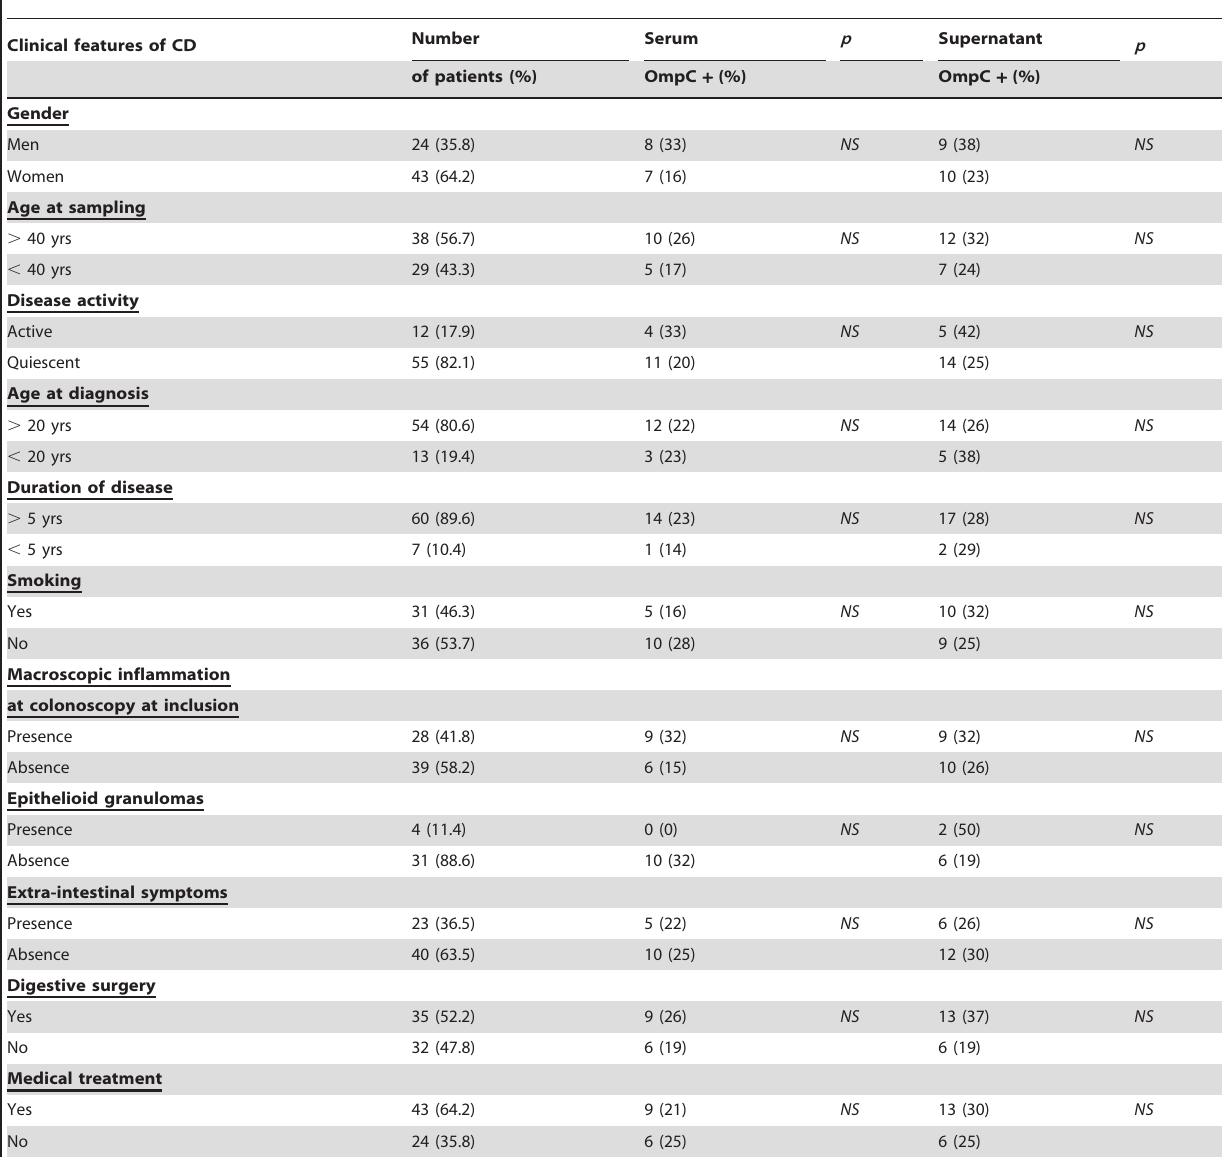
Table 4. Study of correlation between anti-OmpC antibodies status and CD clinical features.